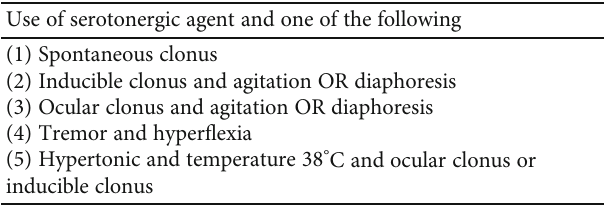
Table 2: Hunter criteria for serotonin